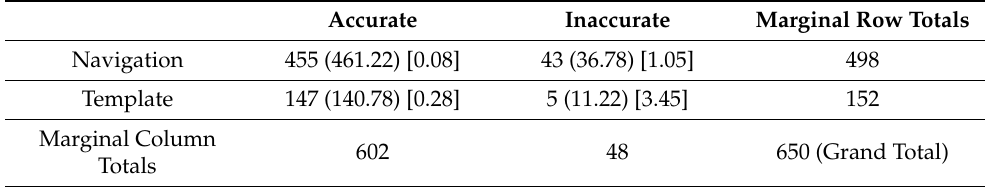
Table 5. Templates are significantly more accurate than Navigation methods. The chi-square statistic is 4.8647. The p -value is